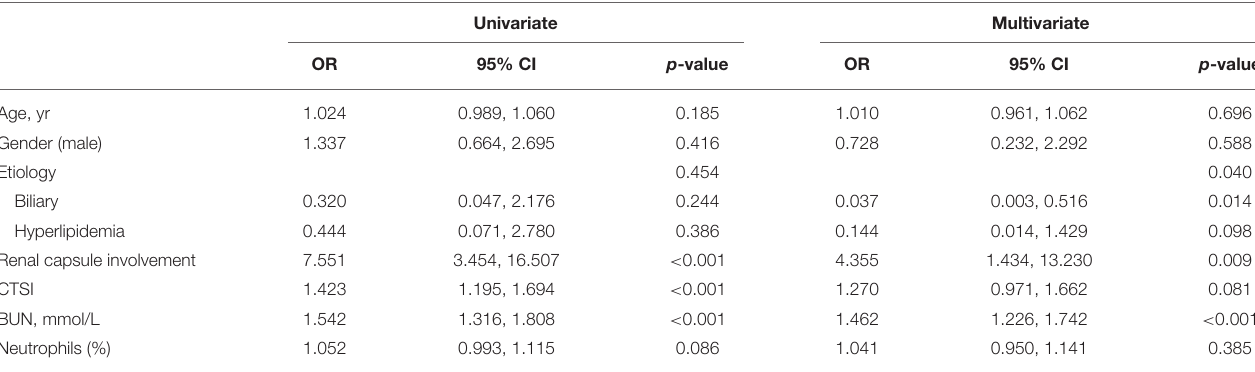
TABLE 3 | Risk factor analysis for AKI in univariate and multivariable logistic regression. Univariate Multivariate OR 95% CI p -value OR 95% CI p